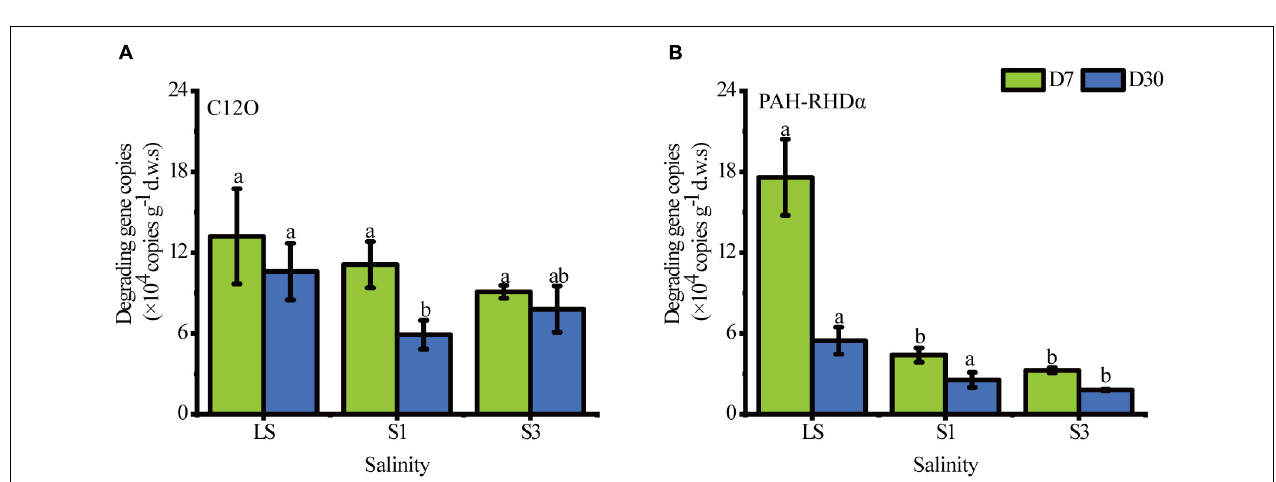
FIGURE 3 | Absolute abundance of the C12O gene and PAH-RHD α gene under the different salinity treatments. (A) the gene of C12O, (B) the gene of PAH-RHD α . Different letters over columns represent significant differences among treatments at the p < 0.05 level of LSD post hoc comparison